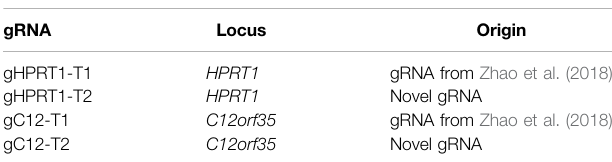
TABLE 1 | Utilized guide RNA